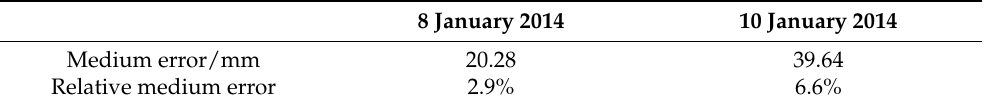
Table 4. Accuracy analysis of model